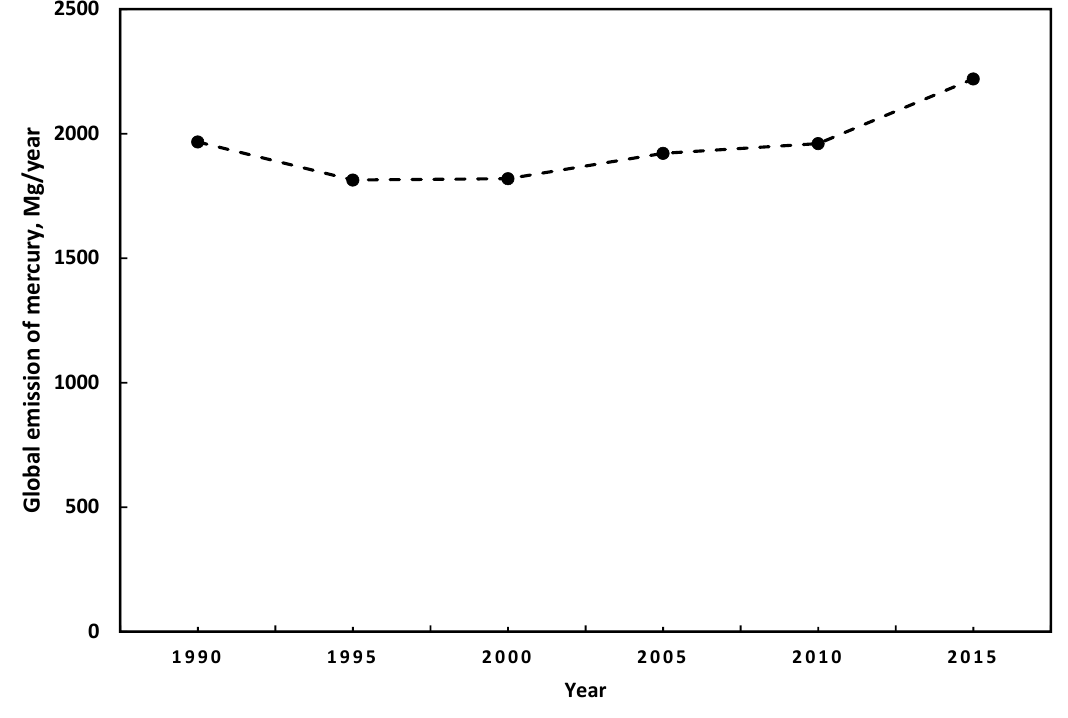
Figure 1. The trend in the global emissions of mercury to air from anthropogenic sources [21,27]. The percentage contribution between anthropogenic and natural emissions depends on the model used to estimate the emissions. Indeed, the anthropogenic/natural ratio can be different for diverse models. For instance, using the GEOS-chem model, the ratio could be 0.583 and using the GRAHM model it could be 0.629 [9]. However, considering a nat-